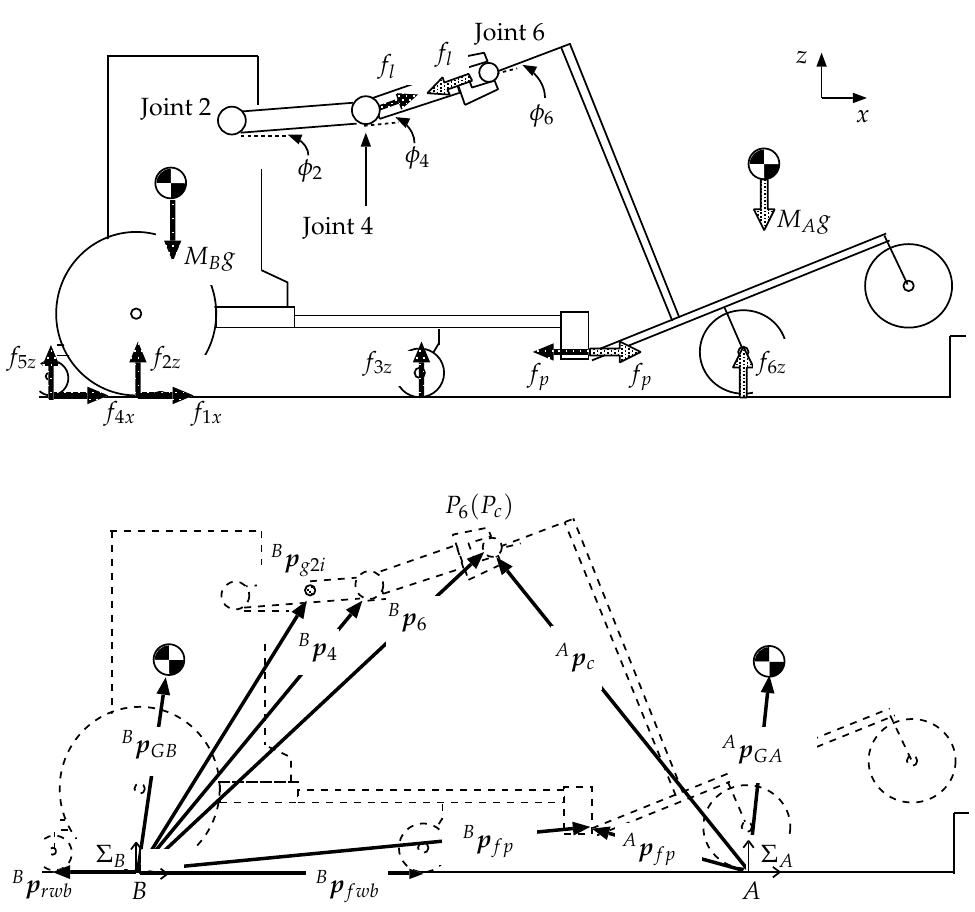
Figure 17. Model showing lifting of the front wheels of the hand cart